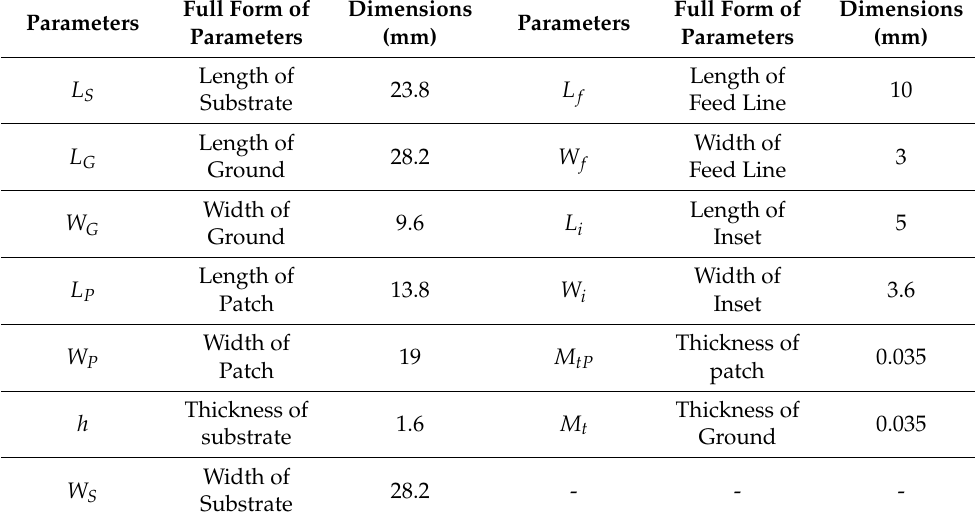
Table 1. Antenna design